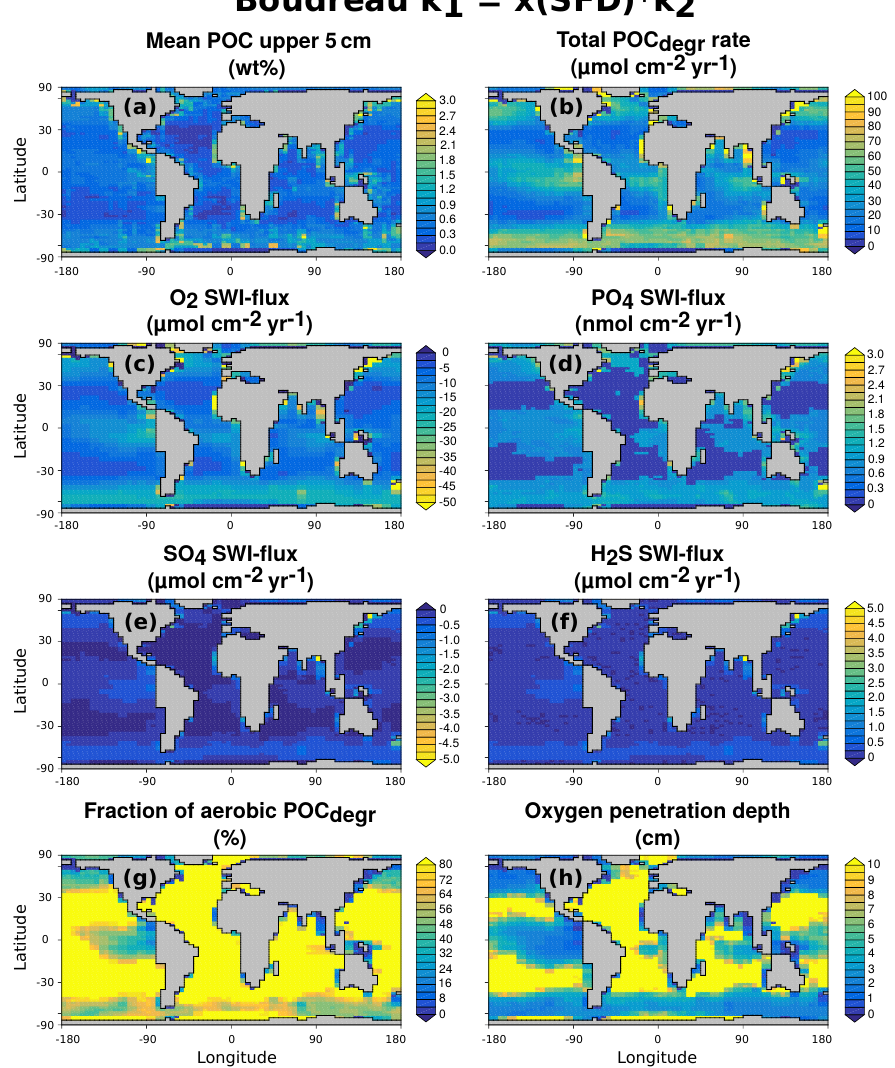
Figure 14. Sediment characteristics related to POC degradation and oxygen consumption for the depth-dependent parameterisation after Boudreau (1997) with k 1 = x( SFD ) · k 2 . Total POC degr rate and fraction of aerobic POC degr are the respective values for the first 5cm in the